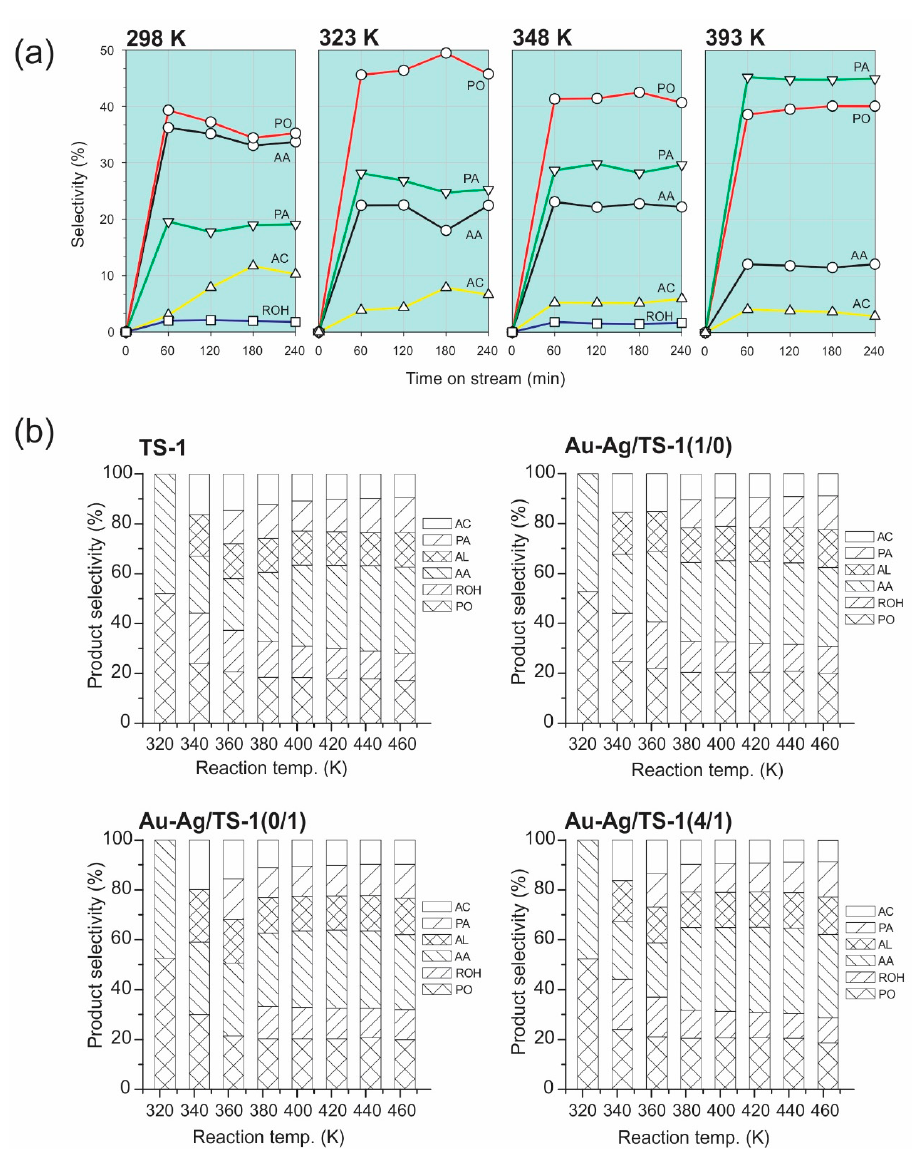
Figure 6. The selectivity to products for different temperature conditions: ( a ) V-Ti/MCM-41, reproduced with permission from [15] ; and ( b ) Au-Ag/TS-1 photocatalysts, reproduced with permission from [42] . Abbreviations: propylene oxide (PO), propionaldehyde (PA), acetone (AC), acetaldehyde (AA), acrolein (AL), and ethanol (ROH).